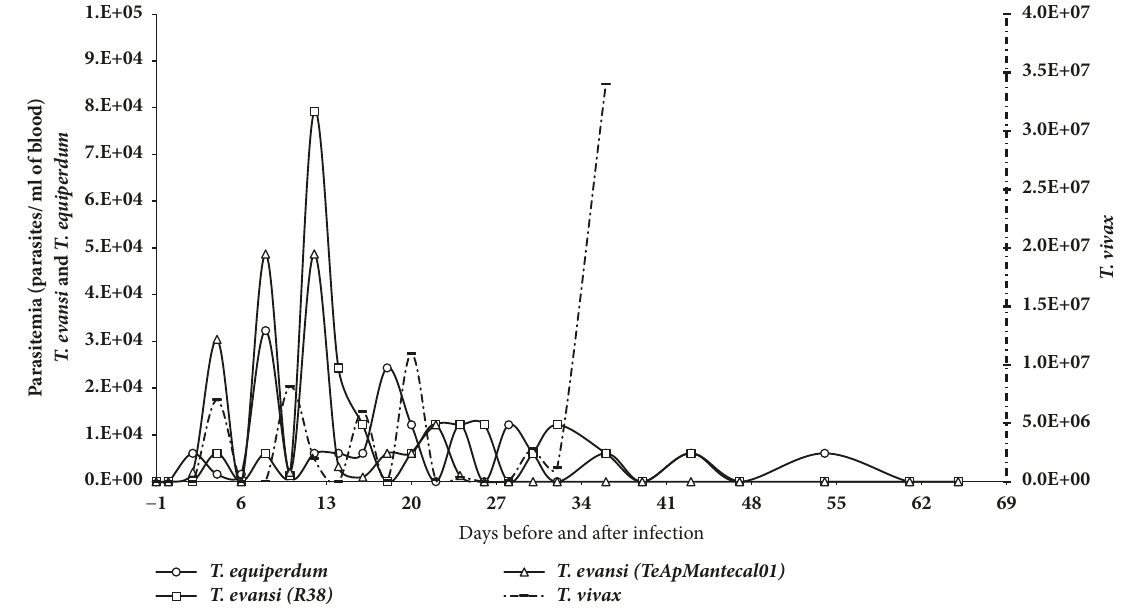
Figure 1: Parasitemia score in experimental ovine infection by Trypanosoma evansi (TeApMantecal01 and R38), Trypanosoma equiperdum (TeAp-N/D1), or Trypanosoma vivax (Tucacas) isolates. Sheep were inoculated intravenously via jugular vein with 1 x 10 6 parasites obtained from infected rats. Parasitemia was determined by direct counting from blood using a Neubauer